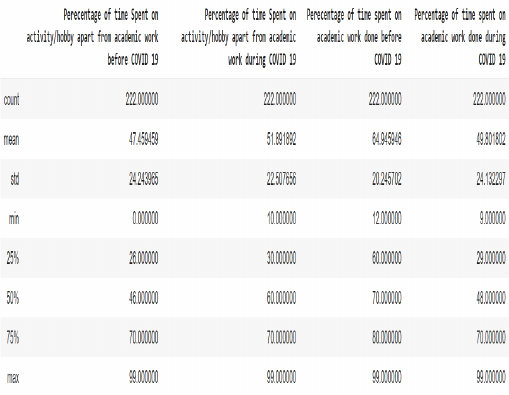
Figure 2. Data analysis of student activity